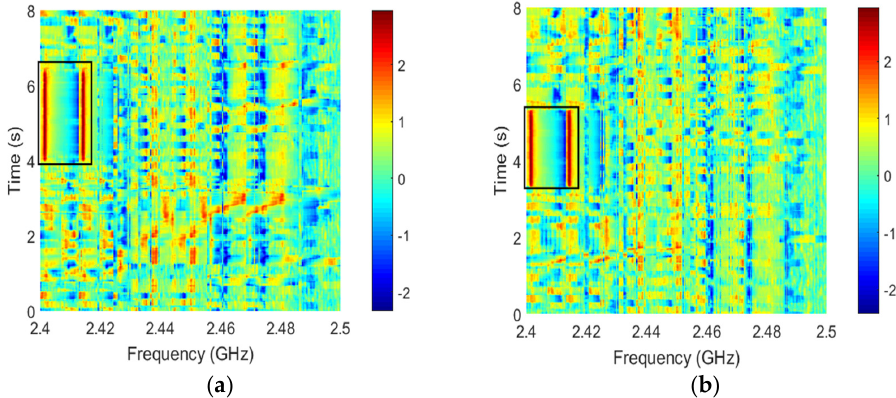
Figure 19. The results for the improved cross-correlation method indoors at distances of ( a ) 5 m and ( b ) 10 m.